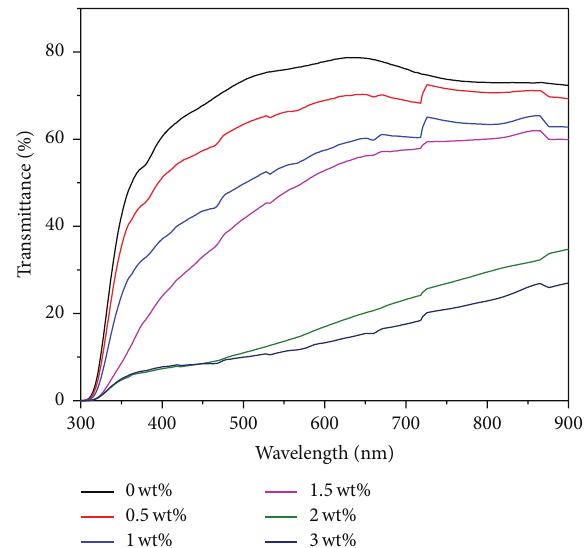
Figure 2: Transmittance spectra of TiO 2 thin films with different wt% of carbon black.